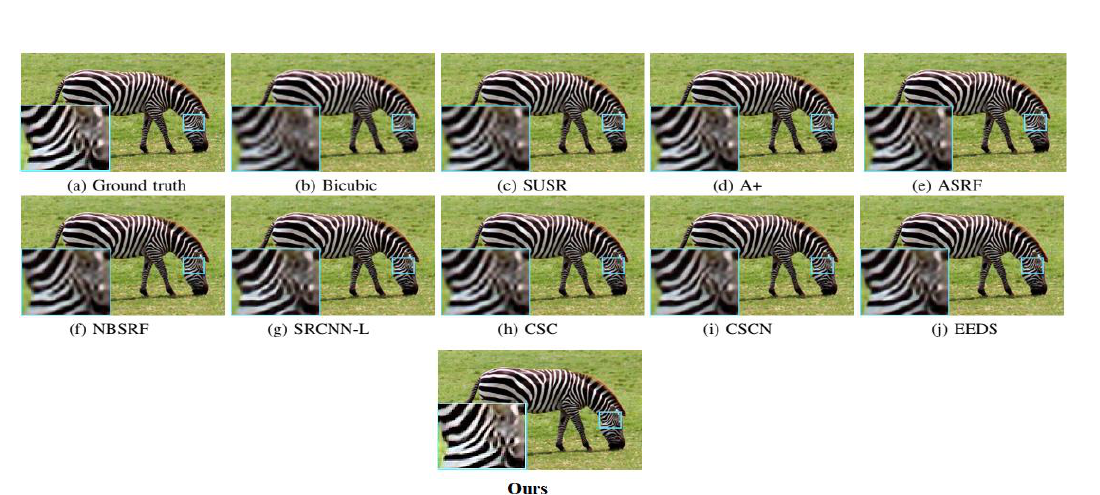
Figure 4. The “barbara” image from Set 14 with an upscaling factor of